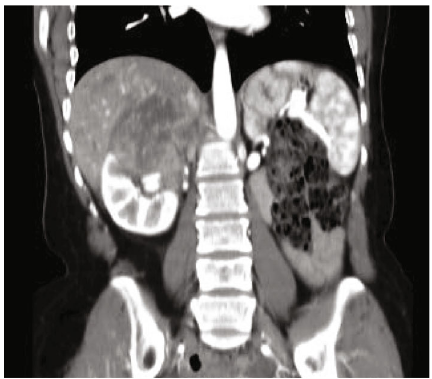
Figure 2: Coronal CT view of the lesion, showing the involvement of the right kidney and